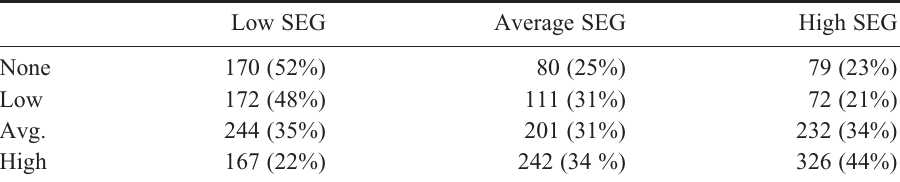
Table 1. Off campus access by socio-economic group (SEG).